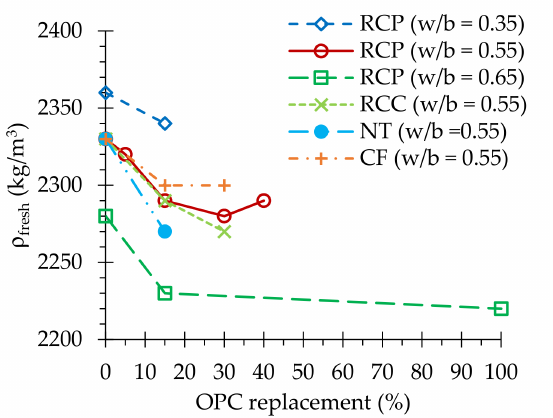
Figure 5. Fresh density, ρ fresh , of concrete with different replacement percentages of OPC with RCP, RCC, NT and CF.